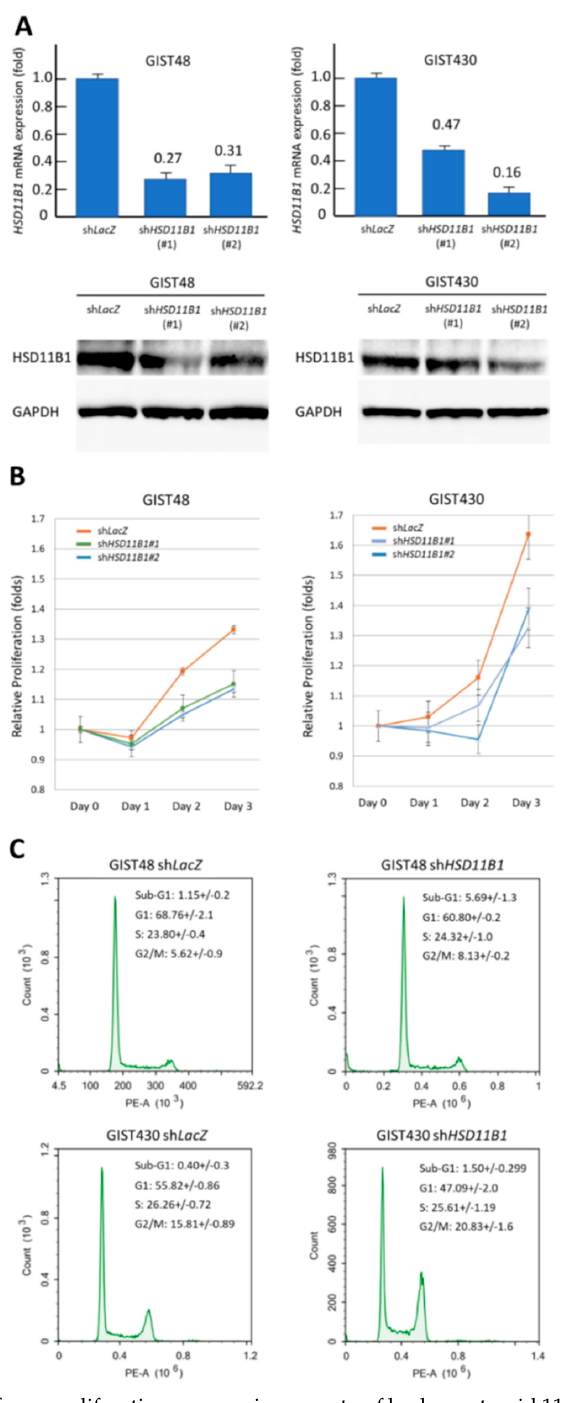
Figure 5. Validation of pro-proliferative oncogenic property of hydroxysteroid 11-beta dehydrogenase-1 (HSD11B1) in the gastrointestinal stromal tumor (GIST) cell models. ( A ) Quantitative RT-PCR (upper) and western blotting (lower) assays validated that stable transduction with either s hHSD11B1 #1 or s hHSD11B1 #2 effectively decreased HSD11B1 mRNA and protein expression levels compared to stable transduction with shLacZ in the HSD11B1-expressing GIST48 (left) and GIST430 (right) cell lines; ( B ) In bromodeoxyuridine BrdU assay, the proliferation rate of GIST48 and GIST430 cell lines significantly decreased from 48 h onwards after transduction with s hHSD11B1#1 or s hHSD11B1#2 ; ( C ) In flow cytometry-based cell cycle kinetic analysis, significantly increased percentages of tumor cells gated at the G 2 /M phase in GIST48 (upper) and GIST430 (lower) cell lines after s hHSD11B1 transduction were observed. PE-A, phycoerythrin